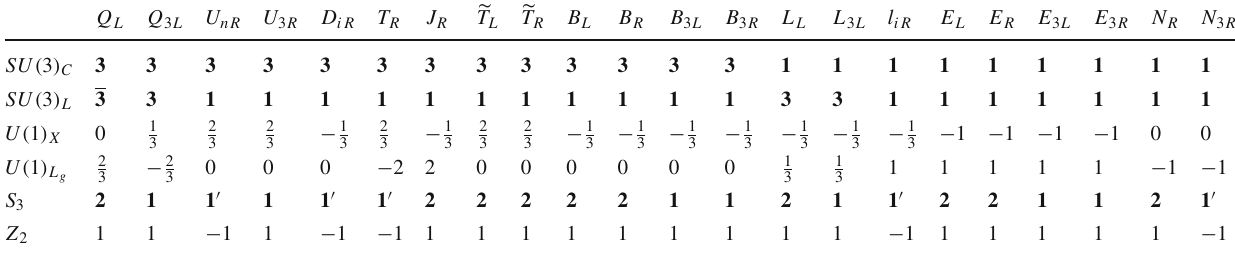
(cid:2) (cid:3) N 1 ( R ) , N 2 ( R ) , N R =